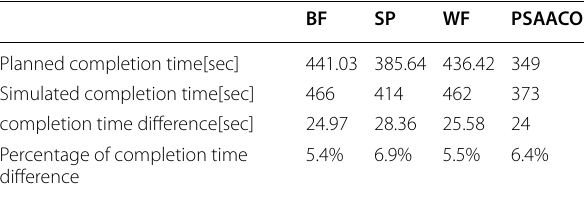
Table 16 Simulation experiment results in Gazebo on CPP